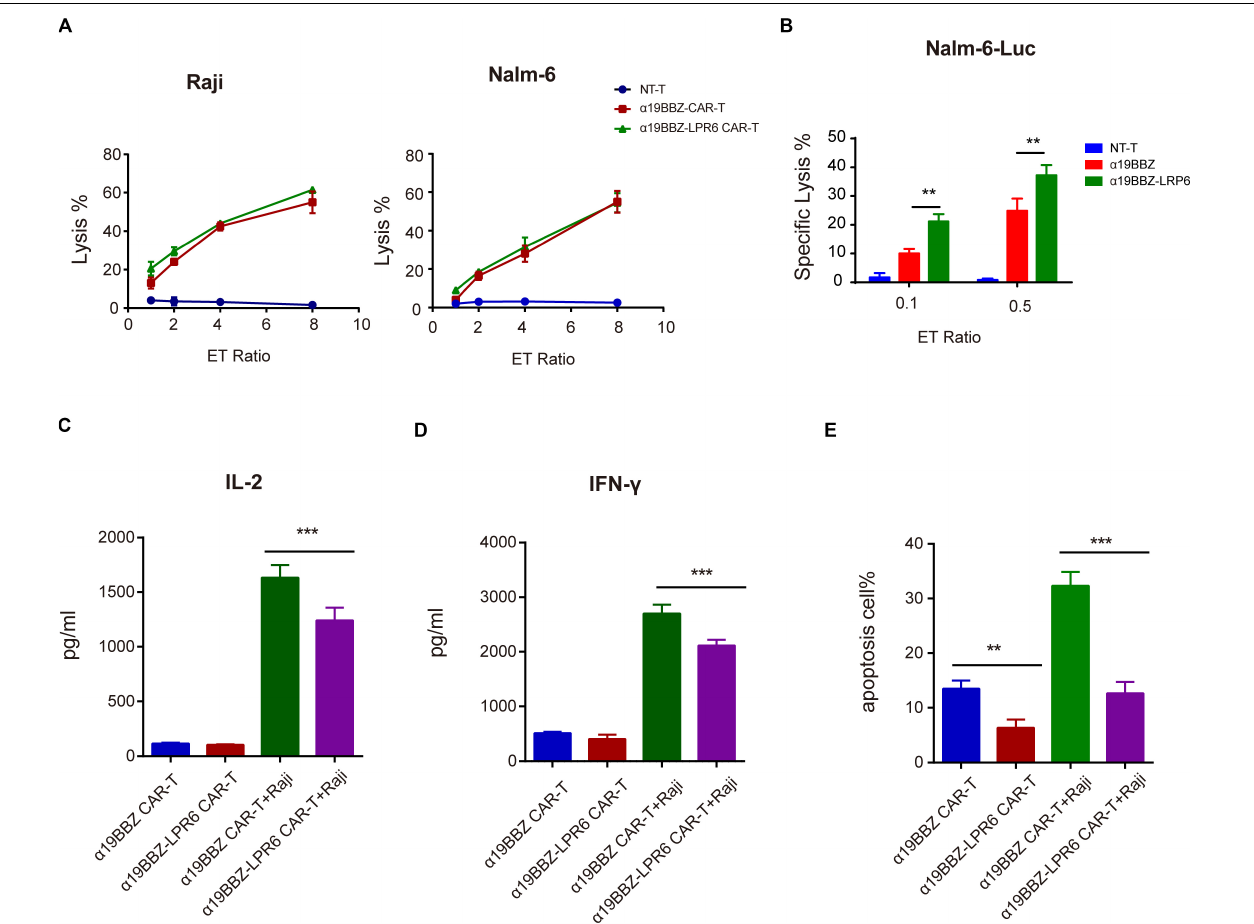
FIGURE 3 | Function of CAR-T to tumor cells. Specific lysis for (A) Raji and (B) Nalm6 for 4 h and against Nalm6-Luc for 18 h. (C) IL-2 and (D) IFN-gamma released. (E) The apoptosis of CAR-T cells after stimulation by tumor cells. Error bars indicate mean ± SD ( n = 3), * P < 0.05; ** P < 0.01; *** P <